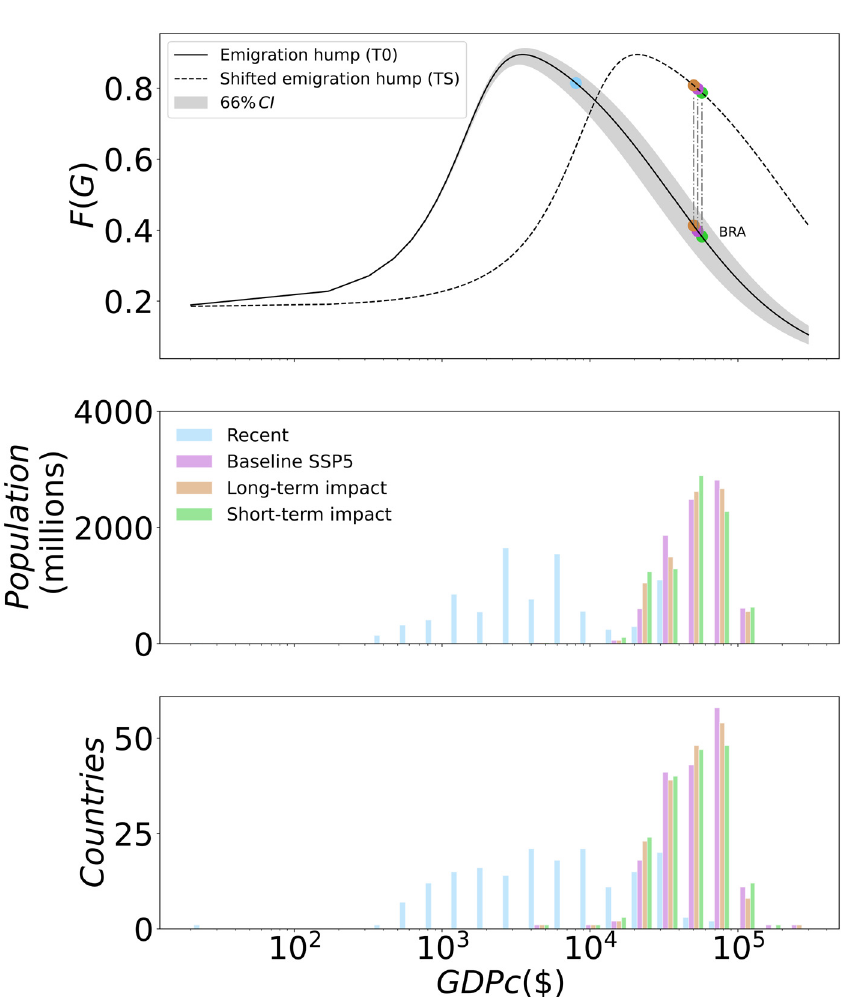
Fig 1. Country level, climate change impact on GDPc under SSP5–8.5 scenario. Positive values represent gains or increase in GDPc under the climate change impact case. The change is calculated as relative to a baseline scenario without climate change impact. Values represent the mean reached within the 30-years period of 3˚C global warming (see Methods). Time averaged values are then averaged along the climate models ensemble. Panels (a) and (b) show the impact for the long-term and short-term impact method